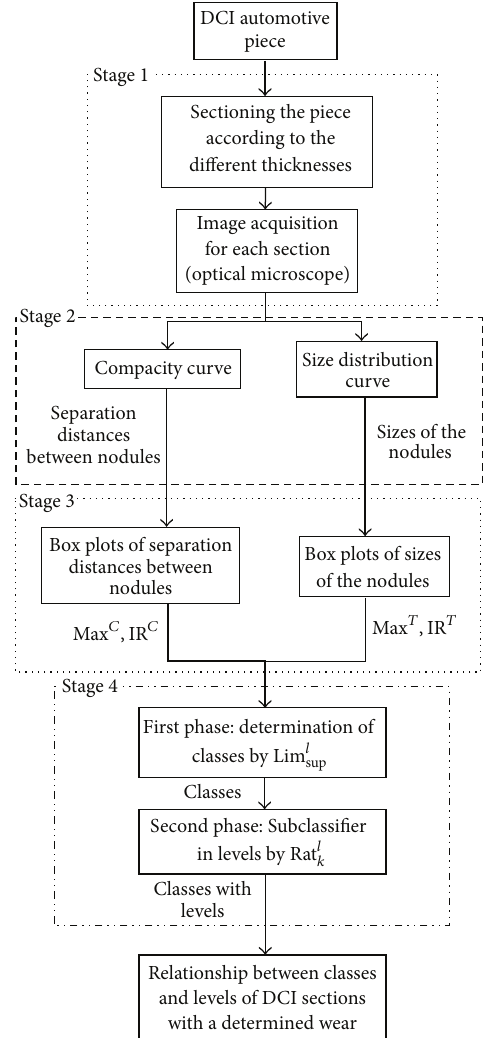
Figure 1: The general diagram of the proposed methodology.